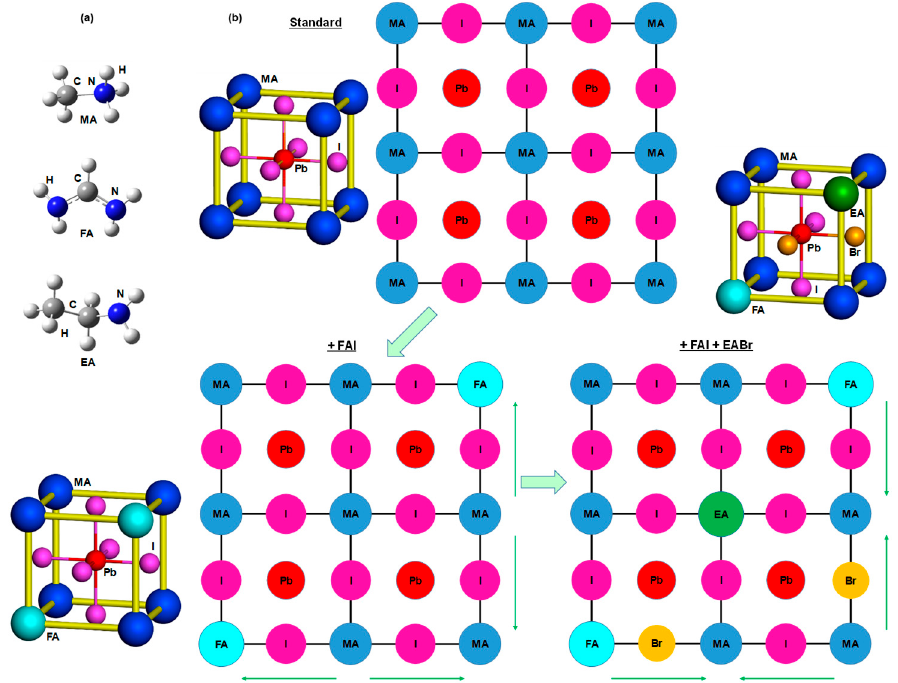
Figure 8. Structures of ( a ) methylammonium (MA), formamidinium (FA), ethylammonium (EA) and ( b ) the present perovskite